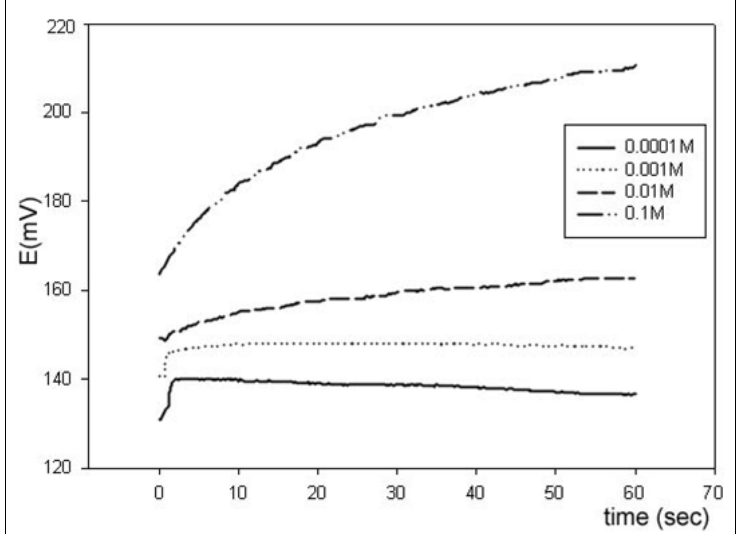
Figure 7. Transient recording of the response of one of the sensors after step changes to different automatically prepared solutions with different calcium concentration